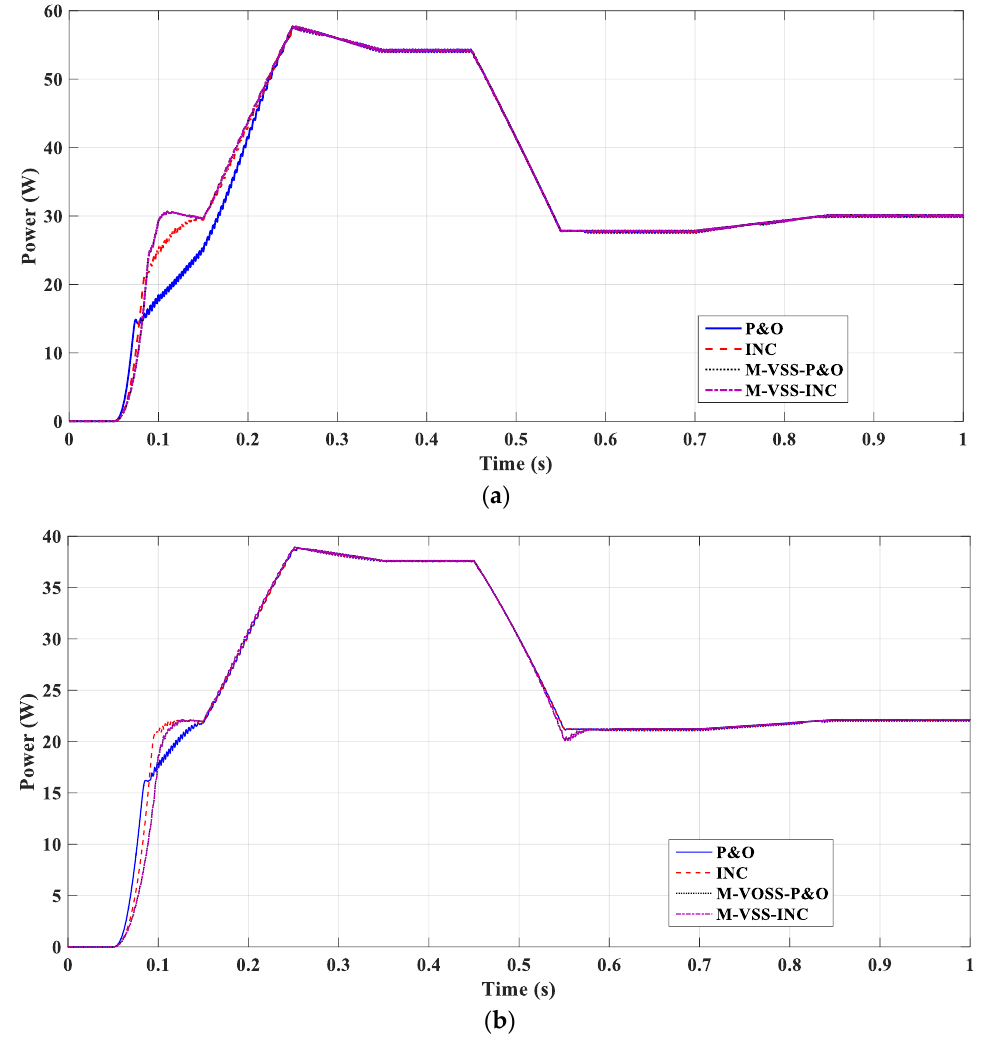
Figure 13. Performance under simultaneous ramp changes in both solar irradiance and temperature: ( a ) MSX60 ( b ) ST40.